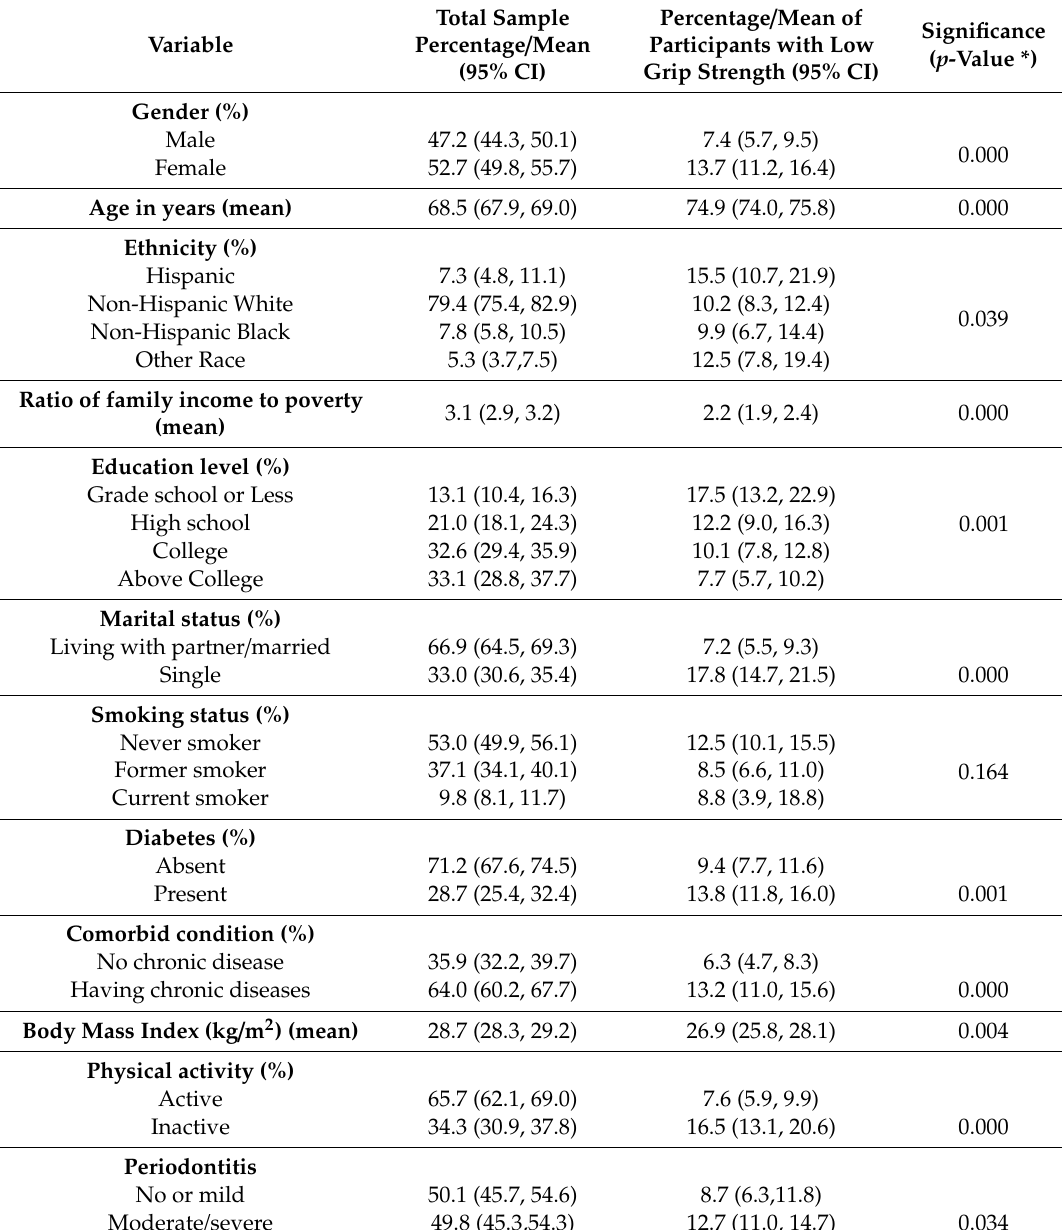
Table 1. Distribution of variables and percentage of low grip strength “cut-o ff points: 26 kg for men, 16 kg for women” prevalence among the 1953 survey participants aged 60 and older, National Health and Nutrition Examination Survey 2011–2014,